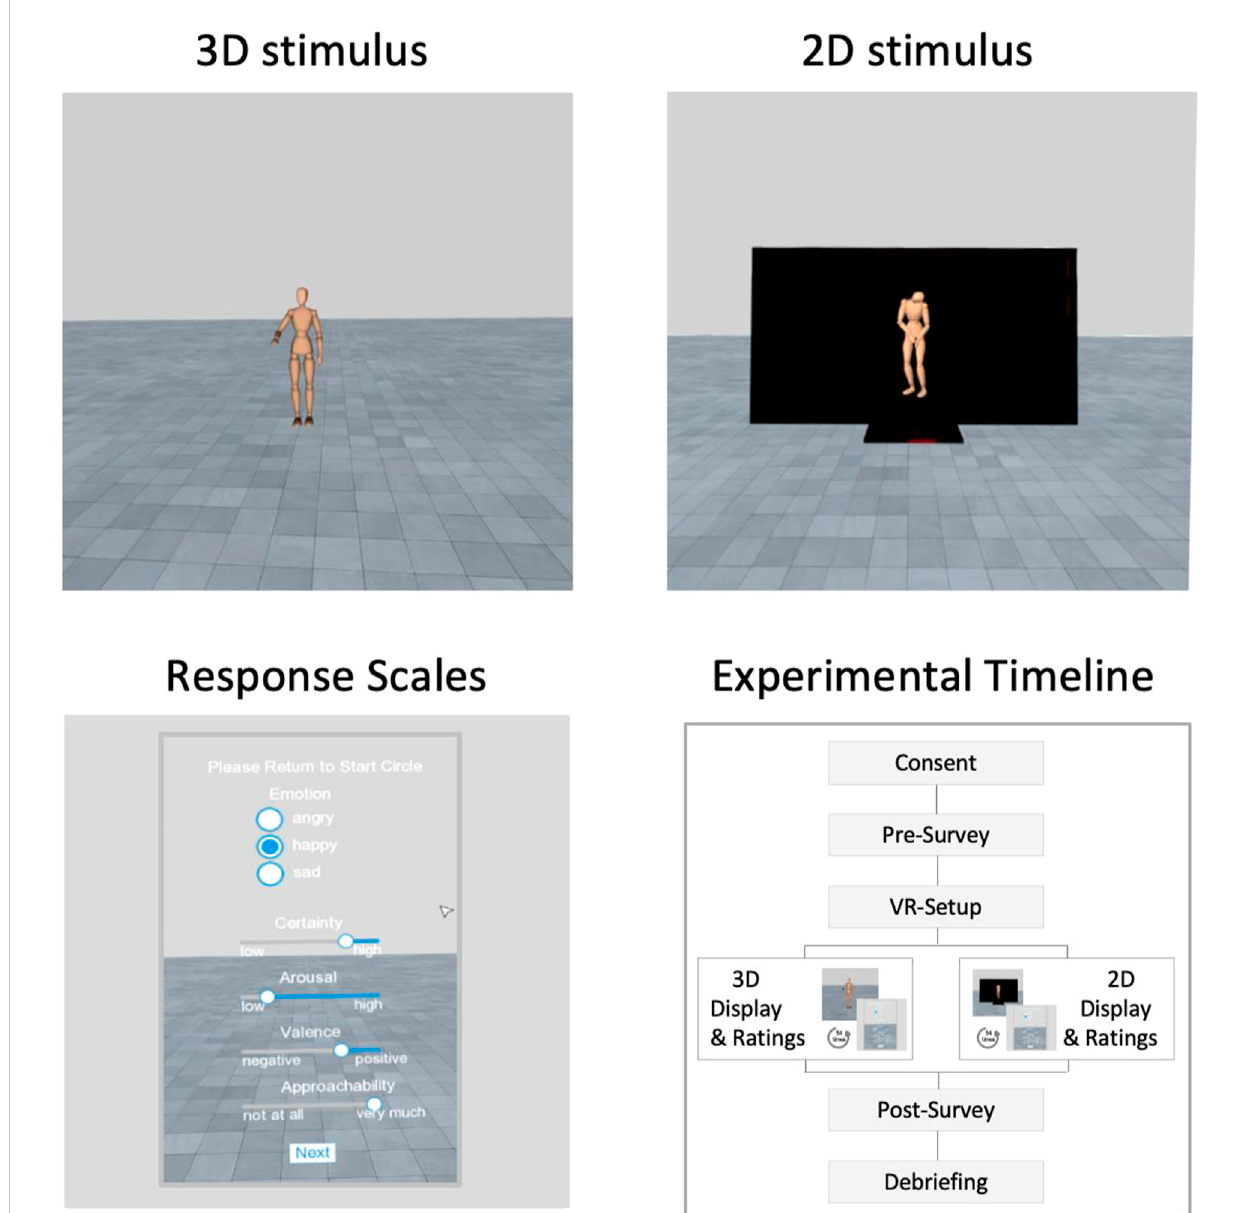
Top row: Presentation modes in the two experimental conditions: 3D stimulus (left: VC standing on the same grounds in the SVE) and 2D stimulus (right: VC shown on TV screen within the SVE). Bottom row: Emotion checklist with rating scales (left) and an overview of the experimental protocol (right). The checklist and rating scale were displayed after each animation clip as an interactive 3D object in the VR environment. Object selection and slider movements were performed using the Oculus Quest 2